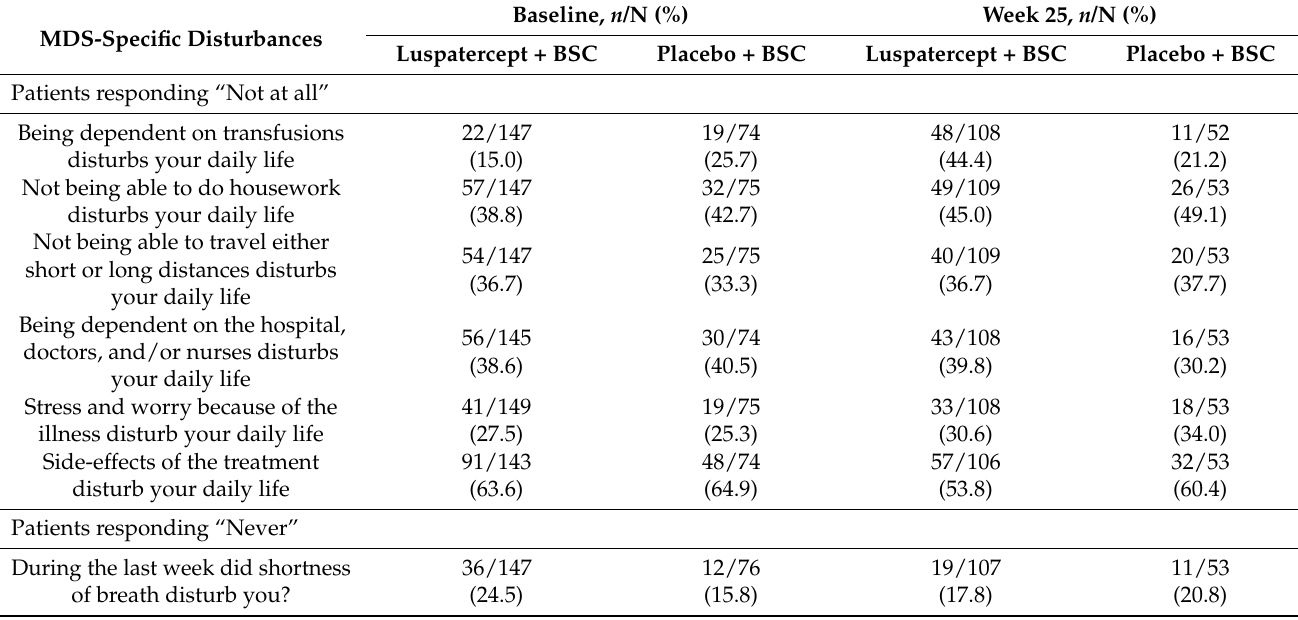
Table 6. Item response on the QOL-E MDS-specific disturbances